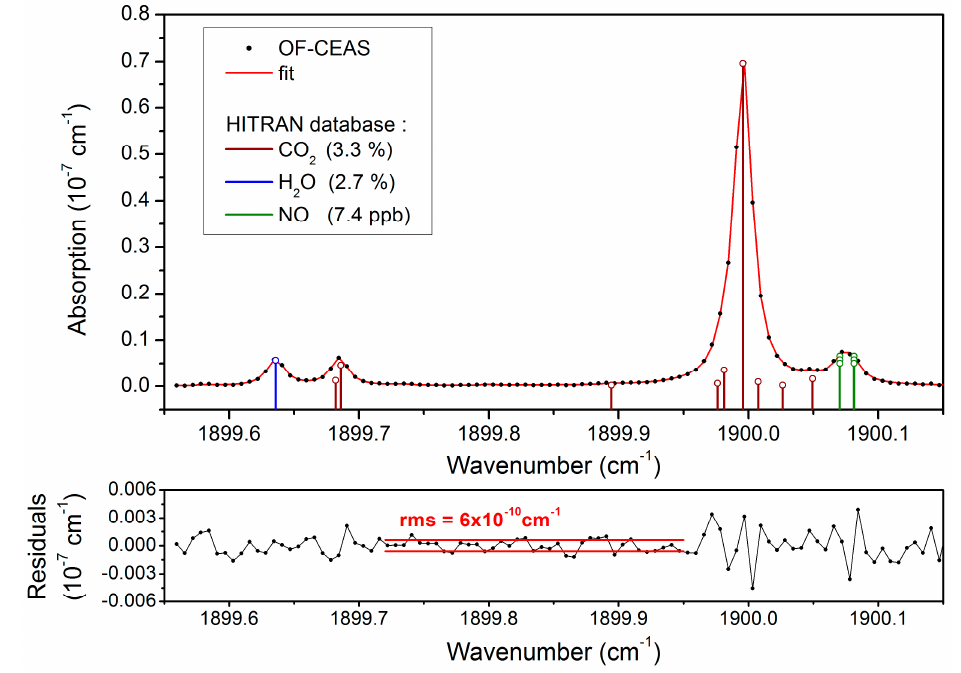
Figure 2. Top: OF-CEAS spectrum of exhaled air (black dots) and its fit (red line). It represents 110 spectral data points, recorded in 180 ms. Baseline and fringes are subtracted. Vertical sticks represent the absorption line derived from a HITRAN-based simulation. Note that each NO doublet line is actually the sum of three coinciding transitions. Given NO concentration is corrected for the saturation effect (see below). Bottom: Residuals of the spectral fit. On the complete scan, the rms is 1.3 × 10 − 9 cm − 1 , while on a region free of absorption line (in red) the rms is as low as 6 × 10 − 10 cm − 1 .